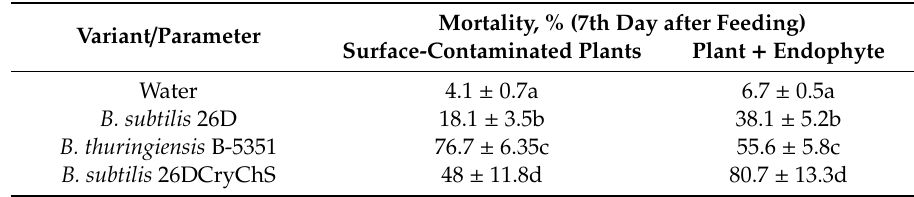
Table 2. E ff ect of feeding on surface contaminated with Bacillus spp. or containing endophytic Bacillus sp. cells in the internal tissues of potato plants on L. decemlineata larvae